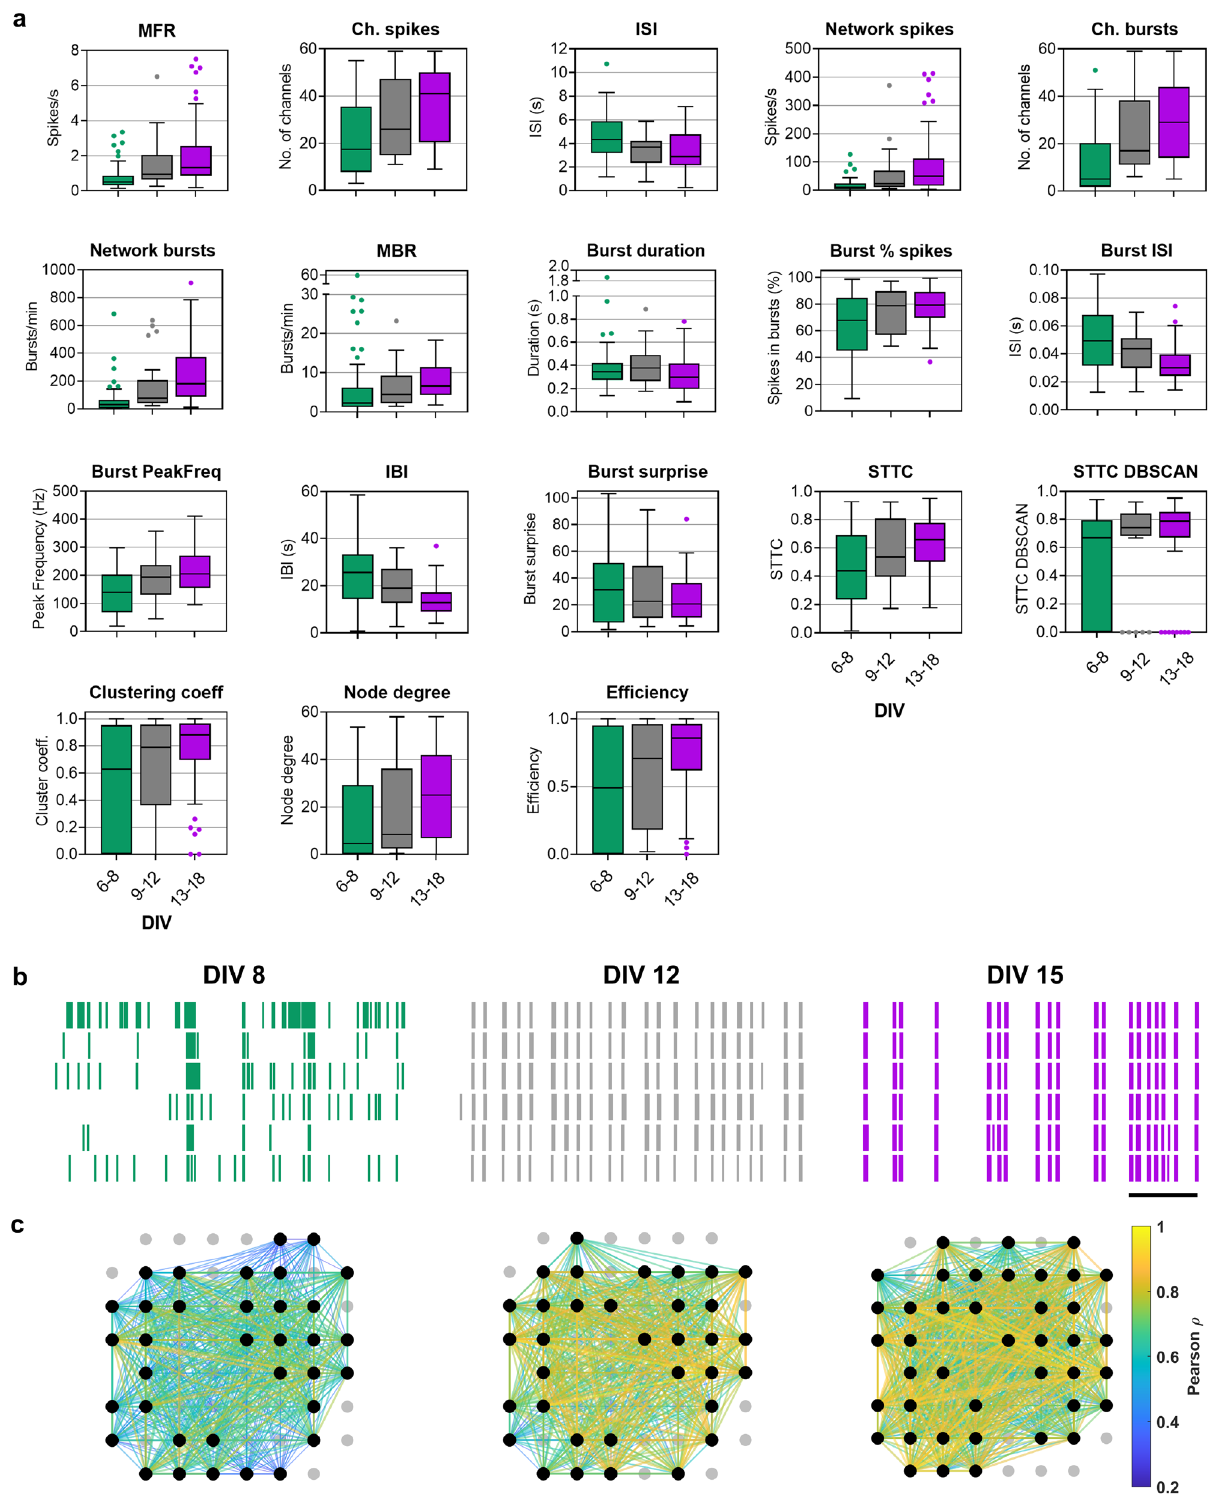
Figure 2. Development of spontaneous activity of cortical neurons in culture during the first three weeks in vitro. ( a ) Analysis of 18 electrophysiological features of neuronal network activity at DIV intervals: 6–8 (n = 50), 9–12 (n = 30), and 13–18 (n = 61). The box plots show the median and the interquartile range with Tukey whiskers. Description of features is provided in Table S1 and p -values for ( a ) are reported in Table S2. (b ) Raster plots show the spontaneous activity recorded by 6 electrodes from a representative neuronal network at DIV 8, 12, and 15 with an archetypical increase of spontaneous activity and synchrony with days in culture. Vertical lines correspond to spikes. Horizontal scale bar, 20 s. ( c ) Maps of functional connectivity of the same neuronal network and period as in ( b ). The color of the connections (edges) between electrodes (nodes) represents Pearson’s correlation and shows a general increase in connectivity during early development. The figure was created using Graphpad 8.0 (https:// www. graph pad. com) ( a ), Neuroexplorer 5 (https:// plexon. com/ produ cts/ neuro explo rer/) ( b ), and Matlab 9.8 (https:// www. mathw orks. com/ produ cts/ matlab. html) ( c